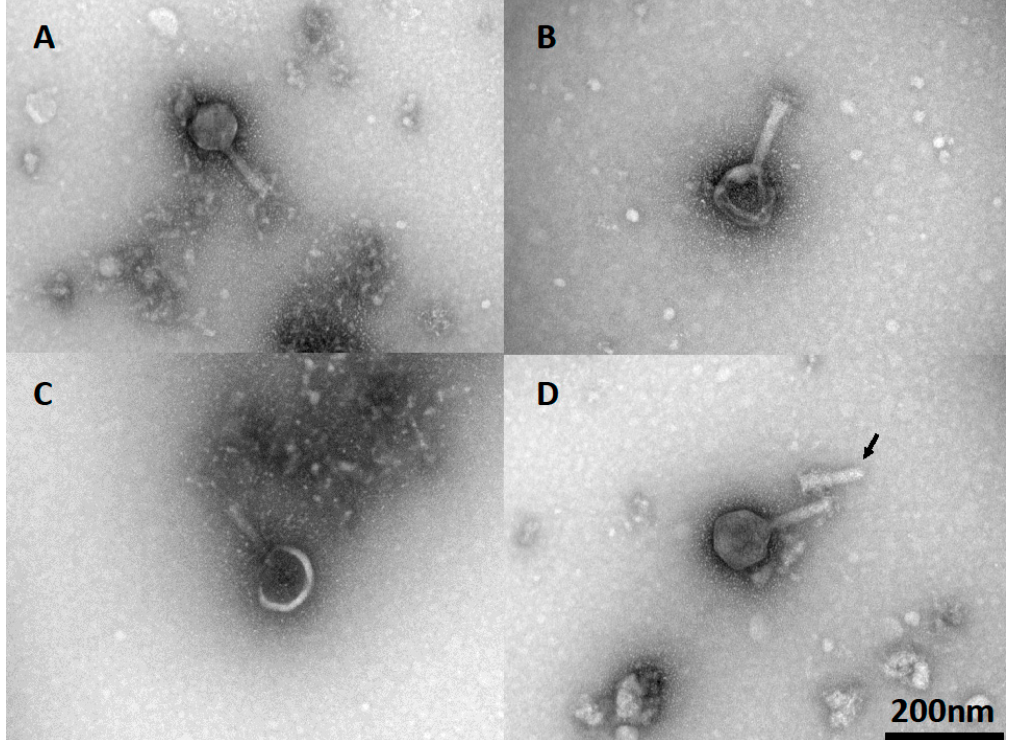
Figure 5. TEM of lyophilized phage CP30A after rehydration. ( A ) Wild-type phage CP30A. ( B ) Phage CP30A with a deformed capsid. ( C ) Phage CP30A with a broken capsid. ( D ) Phage CP30A capsid detached from its tail (arrowhead). The scale bar of 200 nm in panel D is applicable to all panels.